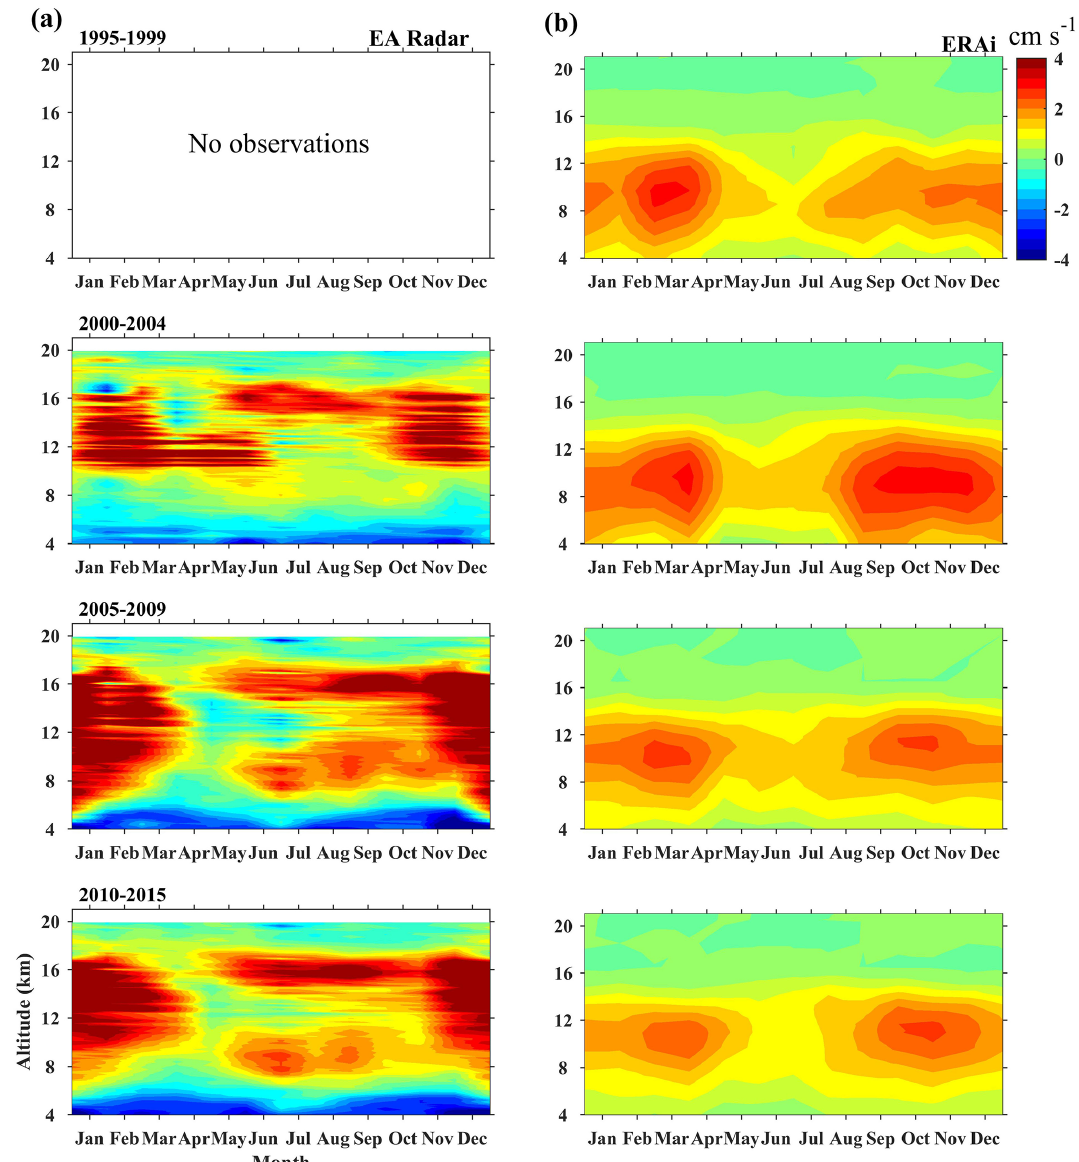
Figure 7. Same as Fig. 6 but for diurnal mean from EAR over Kototabang.